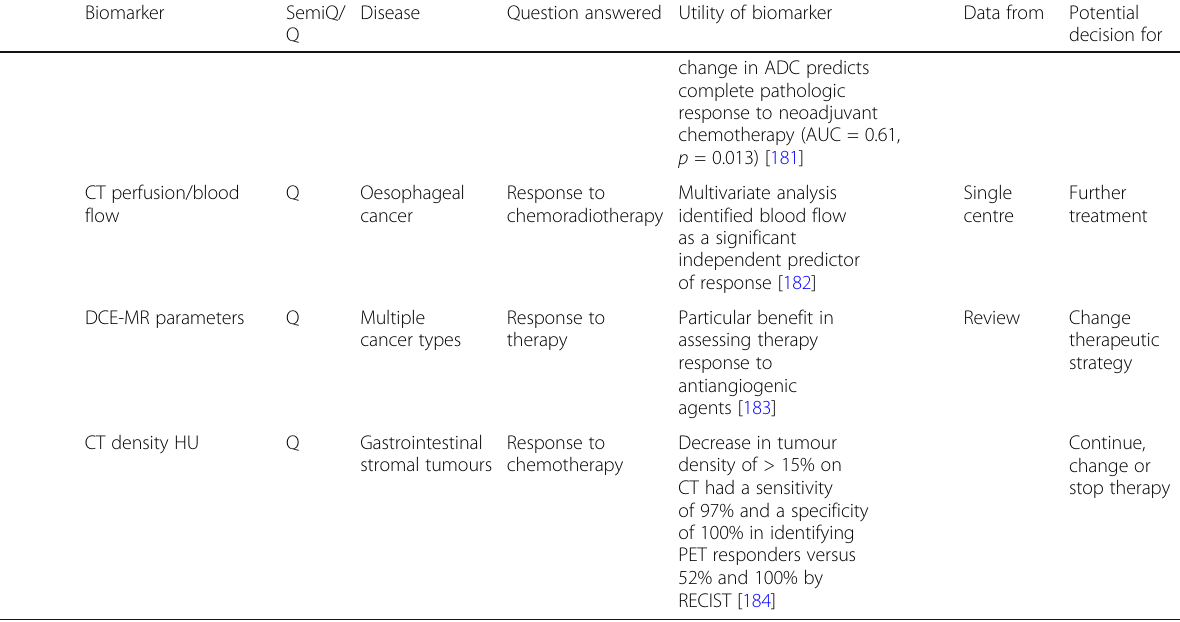
Table 3 Imaging biomarkers for disease response assessment (semi-quantitative and quantitative) with examples of current evidence for their use that would support decision-making (Continued)